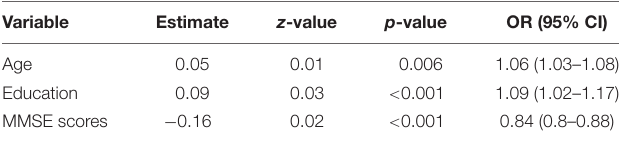
TABLE 2 | Logistic regression model using diagnosis of neurodegenerative disorder as outcome.